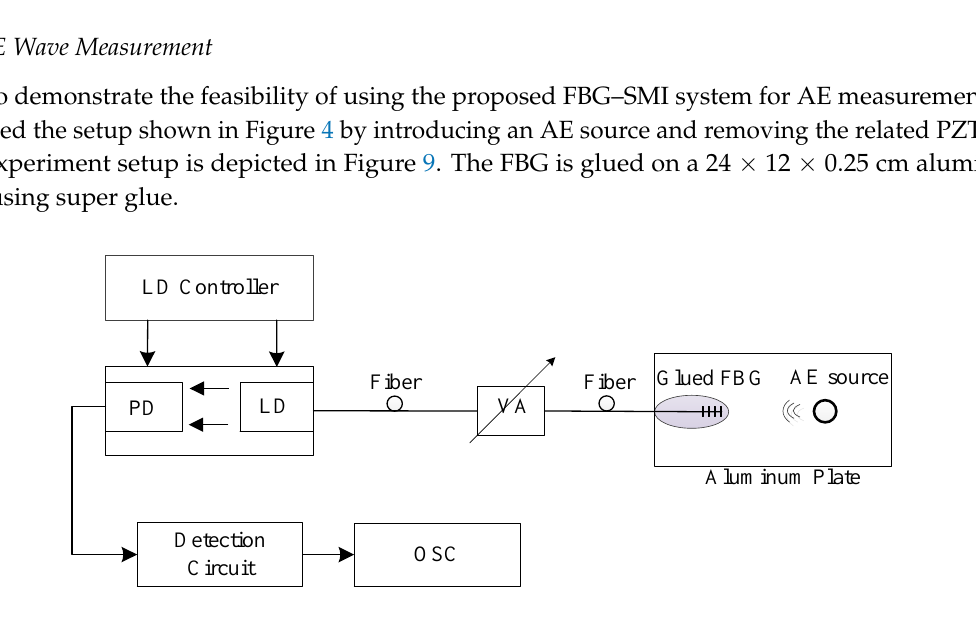
Figure 9. Experimental FBG–SMI system for acoustic emission (AE) measurement.